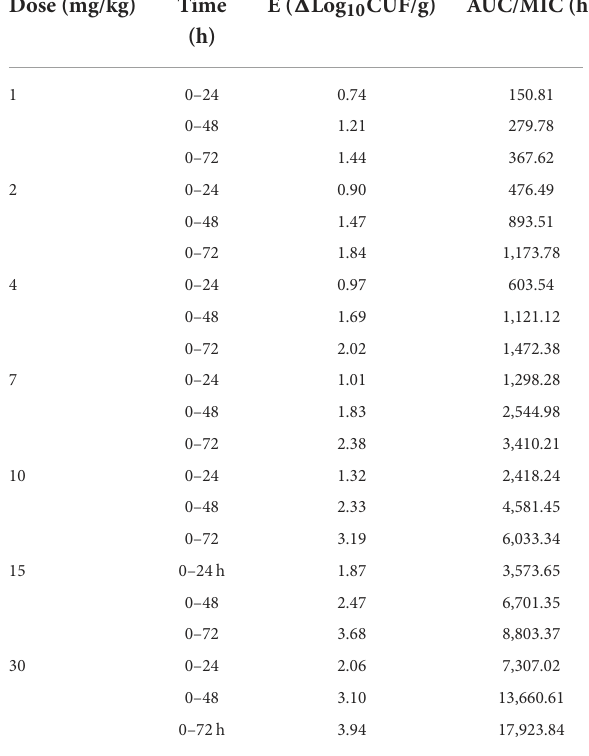
TABLE 2 The Pharmacokinetics/Pharmacodynamics (PK/PD) parameter of AUC/MIC (the area under the concentration–time curve divided by the minimal inhibitory concentration) and the corresponding antimycoplasmal effect in various administration regimens of tilmicosin.